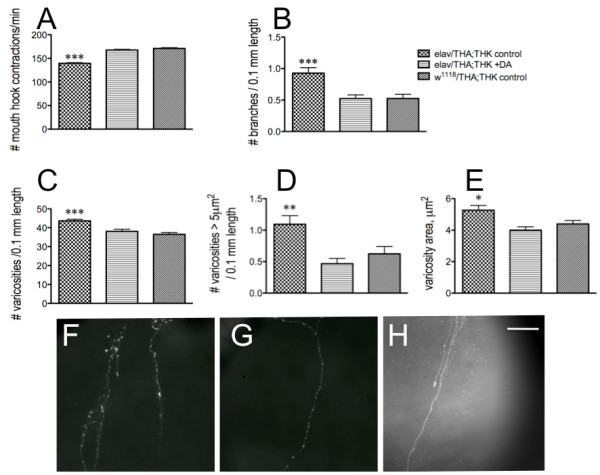
Exposure of elav/THA;THK late-stage embryos to exogenous DA rescues both the feeding and axonal fiber defects. A. Feeding. elav/THA;THK 16 hr old embryos were dechorionated, devitinellated, and placed in serum-free media until hatching (control), or in serum-free media plus 10-6 M DA-HCl (+DA), and compared with w1118/THA;THK 16 hour old embryos placed in serum-free media until hatching. n = 40 for behavioral analyses, from 4-6 independent experiments. B-E. Analysis of the 5-HT axonal fibers projecting to the foregut. B. Number of branches per 0.1 mm length along the axonal fiber. C. Number of total varicosities per 0.1 mm length; D. Number of varicosities > 5 μm2 per 0.1 mm length; E. Varicosity area. w1118/THA;THK, 38 fibers from 30 guts from 8 independent experiments; elav/THA;THK -DA, 40 fibers from 26 guts from 9 independent experiments; elav/THA;THK + DA, 43 fibers from 29 guts from 10 independent experiments. *p < 0.05, **p < 0.01, ***p < 0.001. Statistical analyses were performed using one way ANOVAS and Dunnet's post-tests. Lines above the graph depict standard error of the mean. F - H. Visual depiction of 5-HT axonal fibers from elav/THA;THK (F), elav/THA;THK + DA (G), and w1118/THA;THK (G) guts. Scale bar = 30 μm.